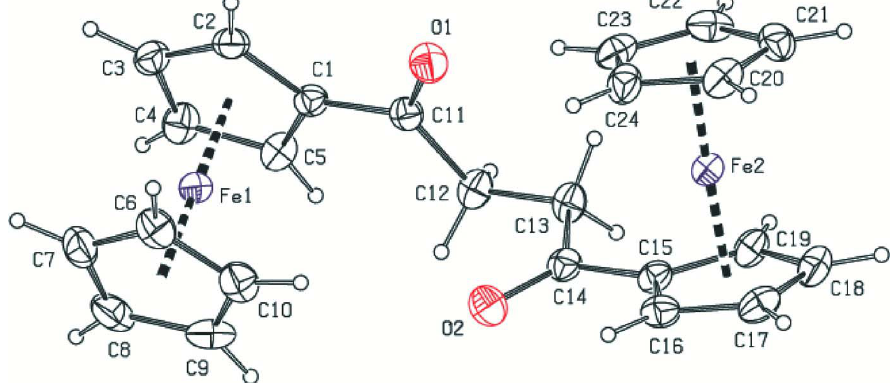
Showing the atom-labelling scheme of (I). Displacement ellipsoids are drawn at the 30% probability